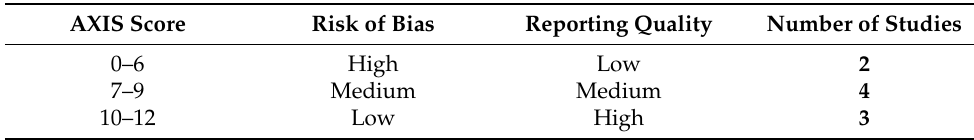
Table 2. Assessment of included studies for risk of bias and reporting quality, according to the modified AXIS tool [26].